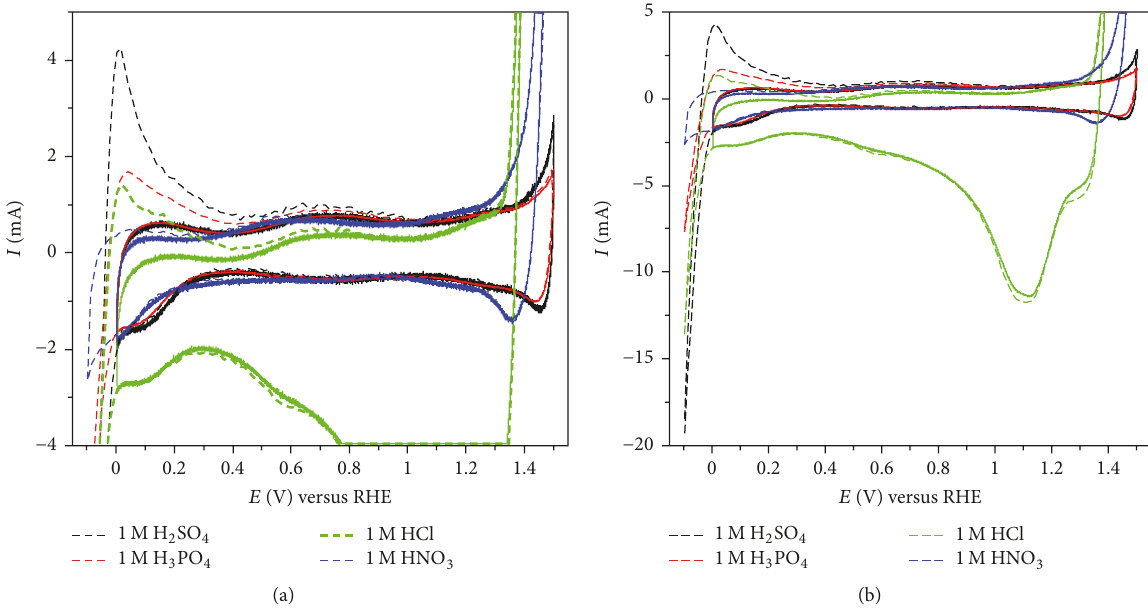
Figure 3: (a) Cyclic voltammograms of acids at 25 ∘ C. Impact of an extended potential window: solid lines: 0 to 1.5 V; dashed lines: −0.1 to 1.5 V RHE. Scan rate: 100mV/s. (b) Full scale to show the oxygen reduction (RuO 4 ) and the impact of chloride at 1.1V RHE.